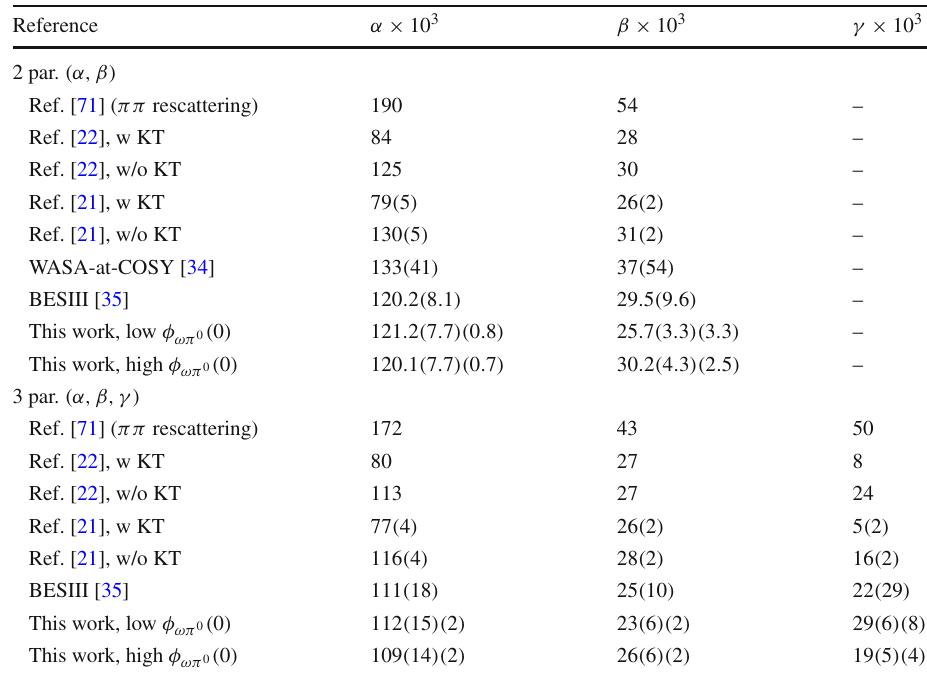
Table 1 Dalitz plot parameters α , β , and γ , obtained by previous theoretical [21,22,71] and experimental [34,35] analyses. For the dispersive analyses [21,22], we show the results obtained with and without KT equations (i.e., with F ( s ) proportional to an Omnés function, see also Sect. 3.3). Also shown are our results, for the two solutions that we find in this work. The upper (lower) part of the table show the results when 2 (3) Dalitz plot parameters are determined. In our results, the first and second error represent our statistical and systematical uncertainties, respectively, as discussed in Sect.